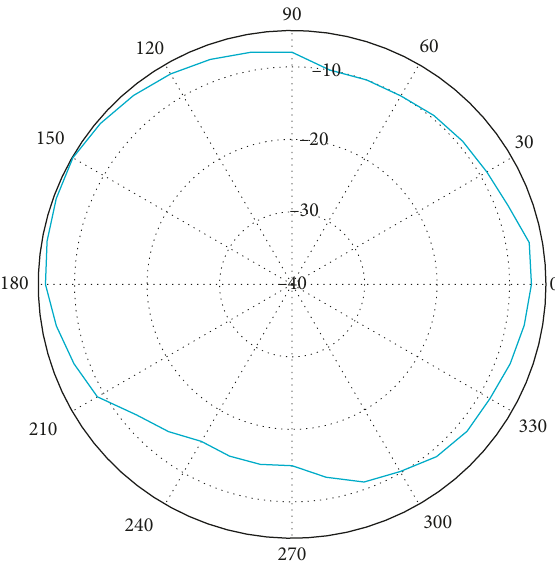
Figure 15: Emission diagram in vertical polarization in the 1 st plane